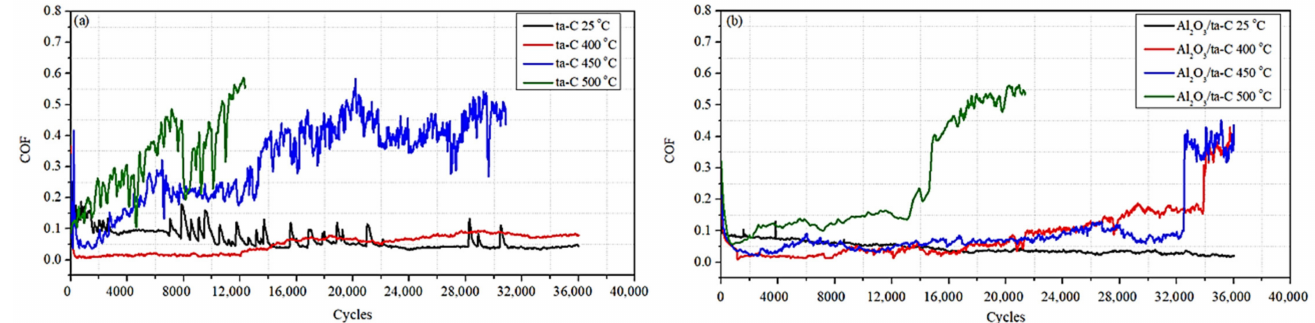
Figure 2. COF versus cycles curves taken on the ( a ) ta-C and ( b ) Al 2 O 3 /ta-C coatings at different